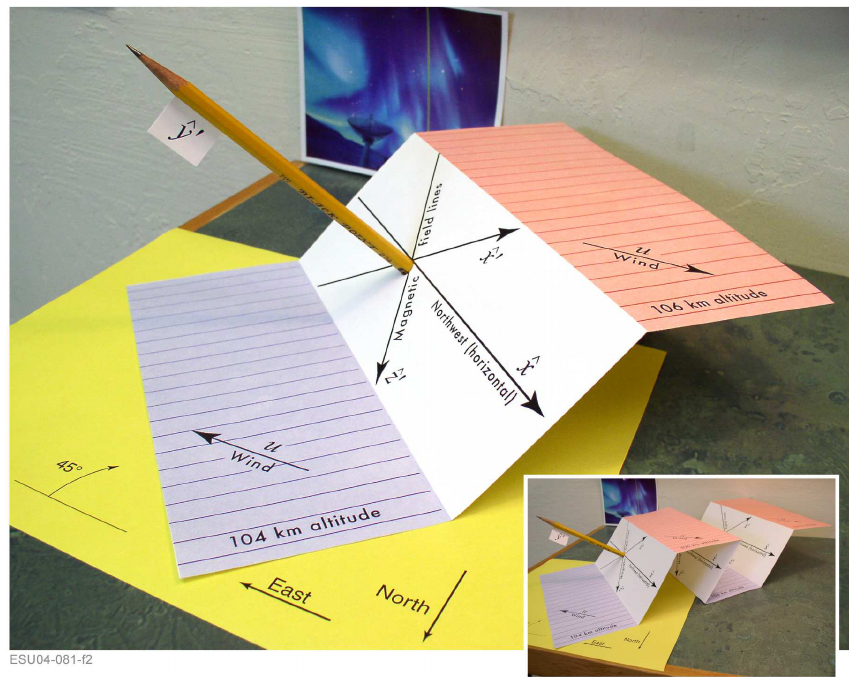
Figure 2: Three-dimensional view of the E s layer instability geometry. Fig. 2. Three-dimensional view of the E s layer instability